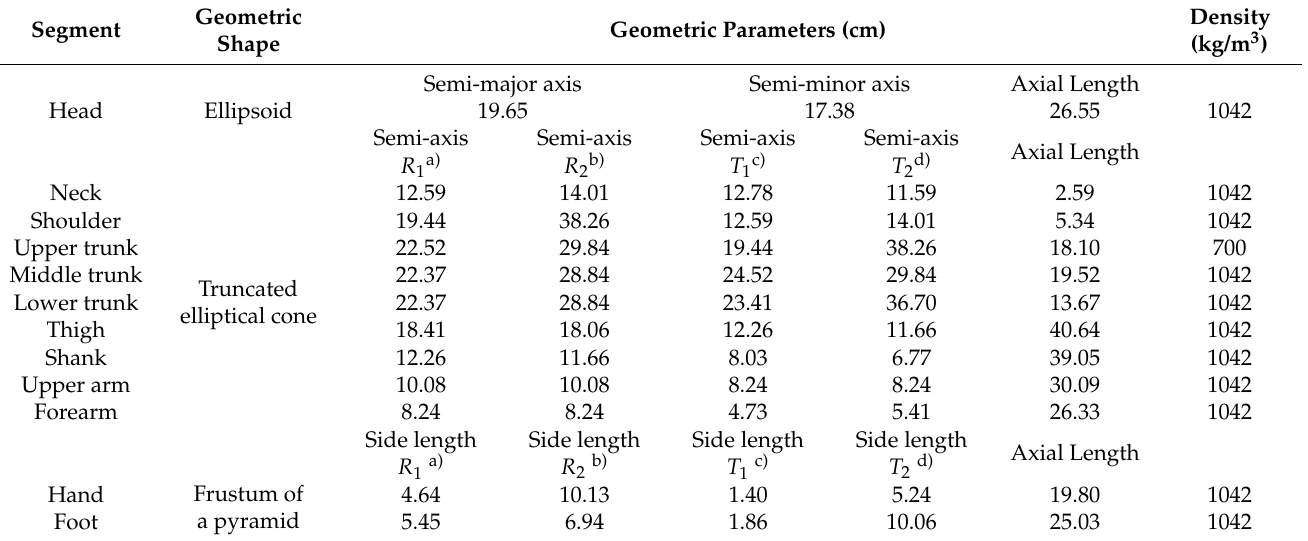
Table 2. Geometric parameters and density of the model segments.